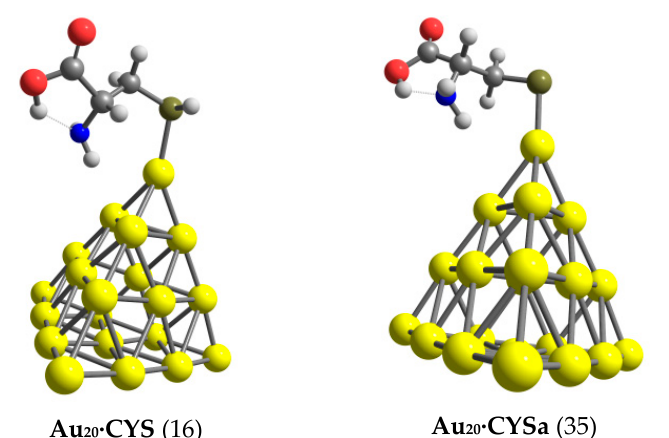
Figure 6. Equilibrium structures for complexes of Au 20 with cysteine (CYS) and its deprotonated form (CYSa). Values in parentheses are binding energies (kcal/mol, PBE/cc-pVTZ/pVDZ-PP + ZPE). The yellow, gray, blue, lime, red, and white balls represent Au, C, N, S, O and H atoms, re- spectively.